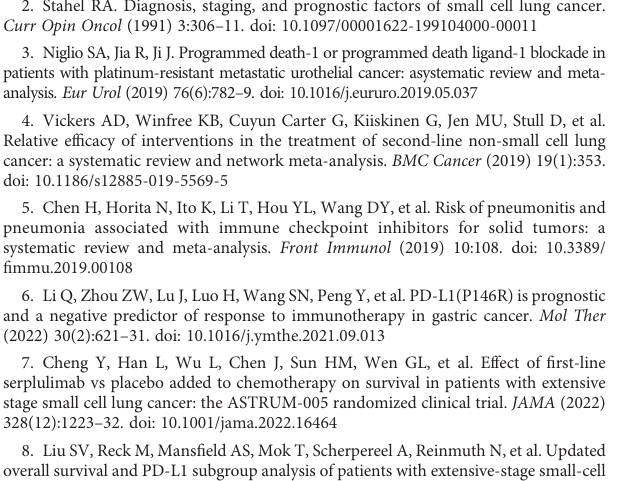
SUPPLEMENTARY FIGURE 1 ROC curves revealing the discriminatory power of two evaluation indicators for predicting (A) OS and (B) PFS in the entire cohort; ROC curves revealing the discriminatory power of two evaluation indicators for predicting (C) OS and (D) PFS in the PSM